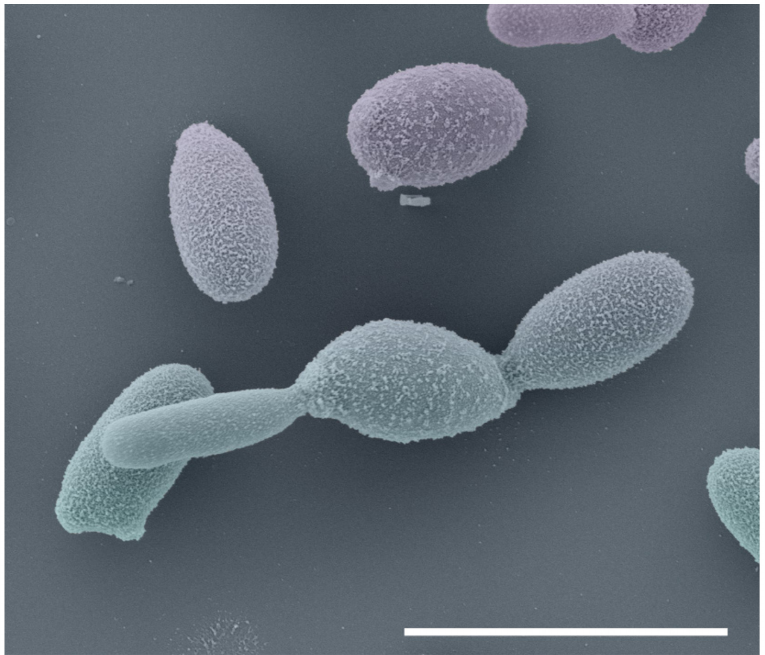
Figure 5. Scanning electron microscopy of Sporothrix brasiliensis yeasts cells (BHI broth, seven days, 37 ◦ C, 100 rpm). Bar = 5 µ m.